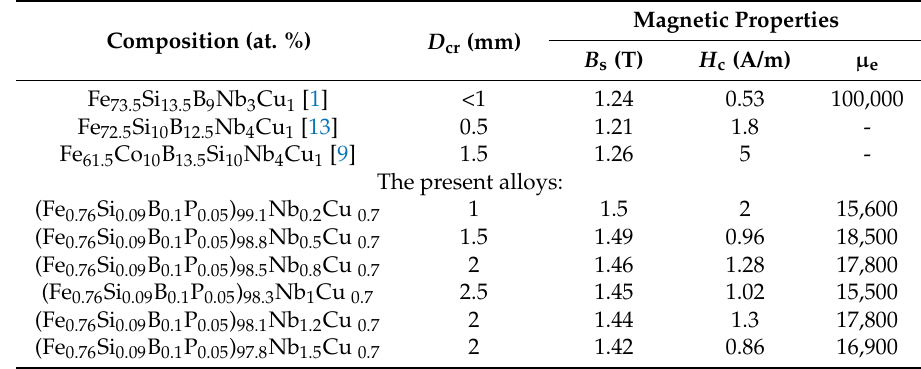
Table 1. D cr and magnetic properties of the present alloys and some Fe-based bulk metallic alloys reported previously. Composition (at.